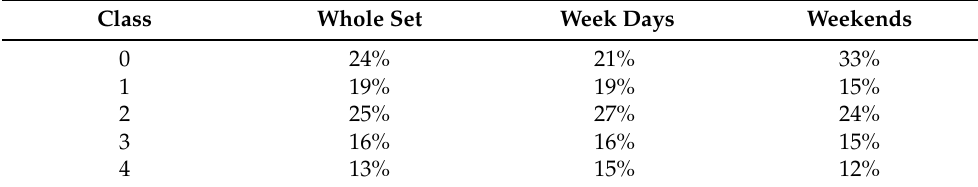
Table 2. Detailed results. Cluster distribution. Whole set, week days, and